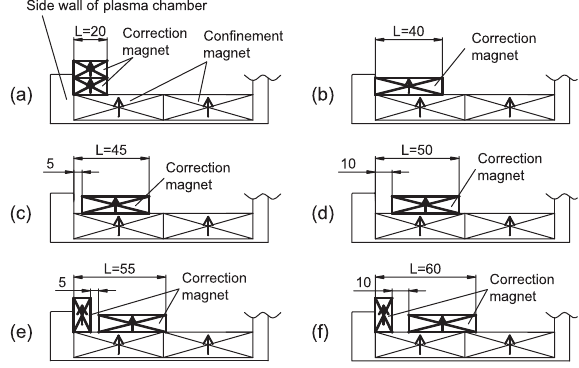
FIG. 4. Dependence of beam current on effective length of correction